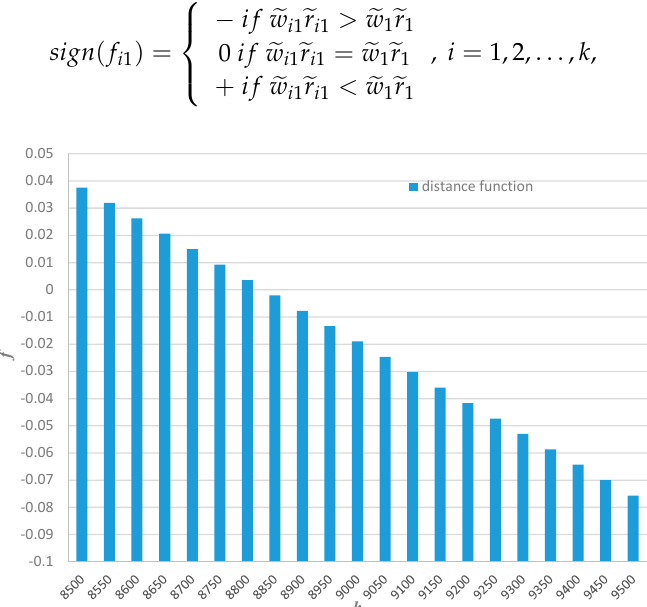
Figure 2. Descending order of the distance function values.